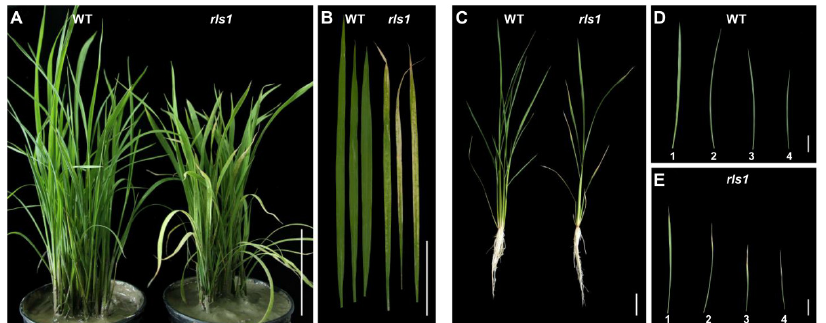
Figure 1. The phenotype of WT (wild type) and rls1 plants. ( A ) Soil-grown seedlings at the five-leaf stage; ( B ) the appearance of fully expanded seedling leaves; ( C ) hydroponics-grown 35 day old plants at the tillering stage; ( D , E ) the appearance of the first, second, third and fourth fully expanded leaf (counting from the apex to the base of the main tiller) of 35 day old ( D ) WT and ( E ) rls1 mutant plants. Bars in ( A , C ): 10 cm, in ( B , D , E ): 5